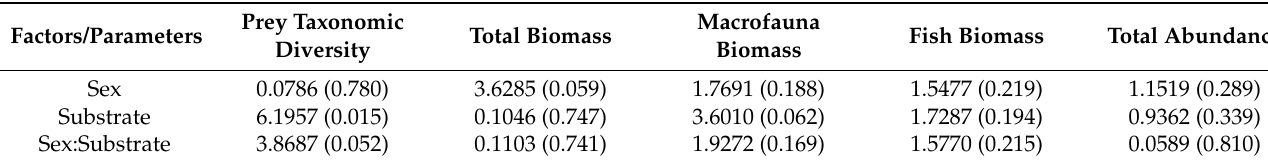
Table 3. Numerical outputs (criteria values and p -values in brackets) of robust ANOVA with trimmed means for different prey characteristics.